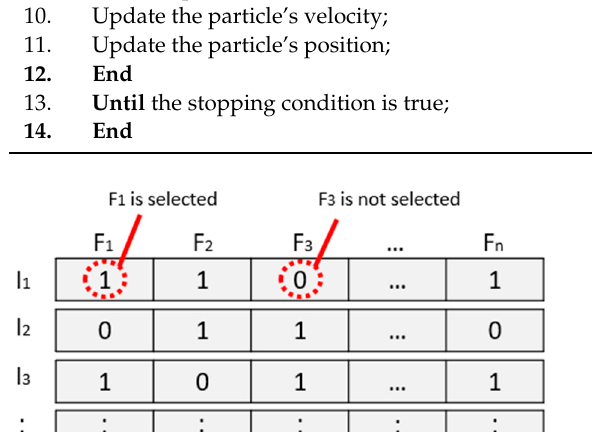
Figure 6. The BPSO process is represented by a particle. Algorithm 1: Pseudocode BPSO in Feature Selection.